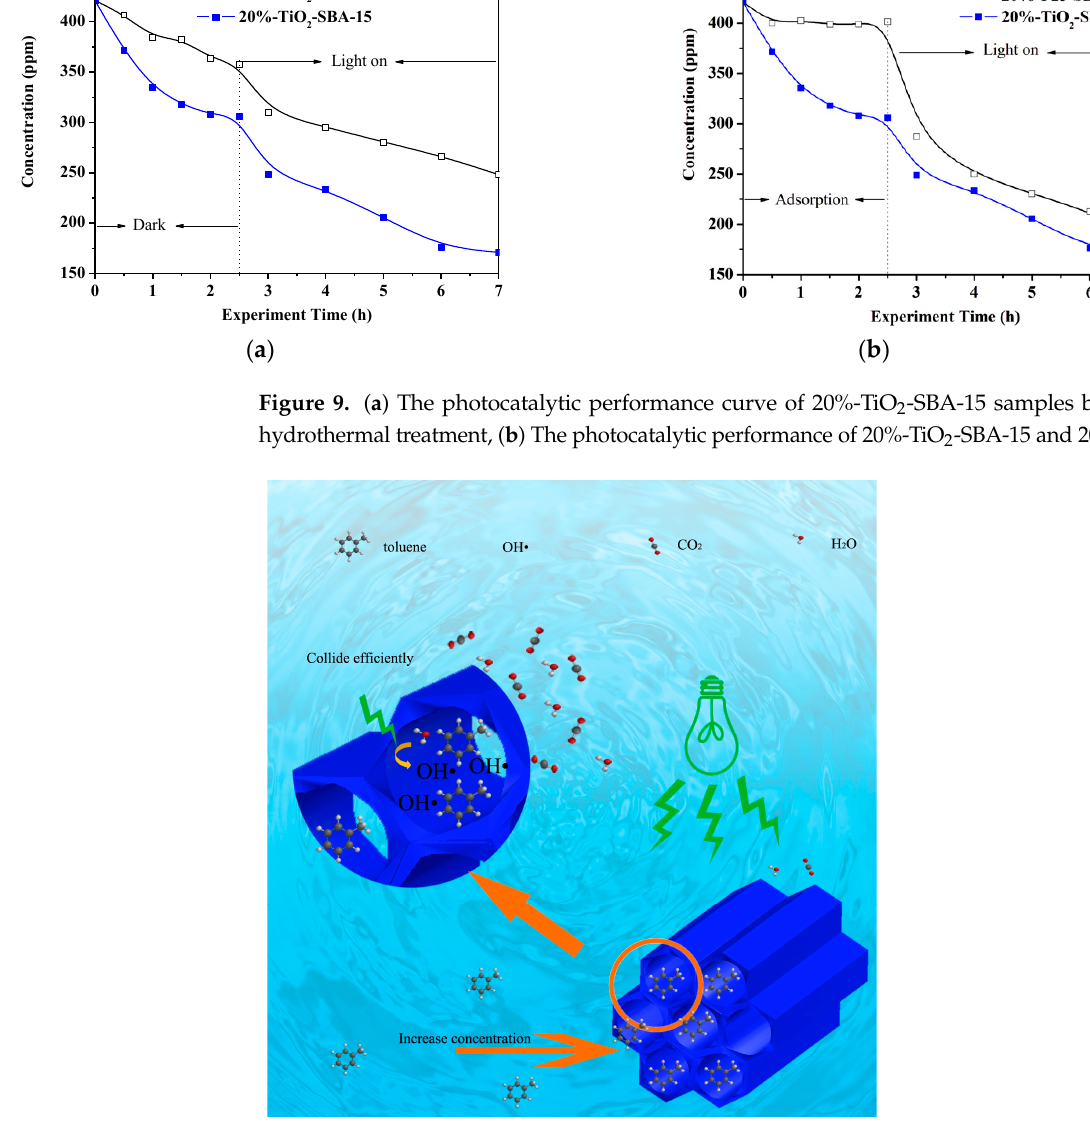
Figure 10. Mechanism of TiO 2 -SBA-15 improves the pollutant concentration and the collision likeli- hood between hydroxyl radicals and Toluene. hood between hydroxyl radicals and